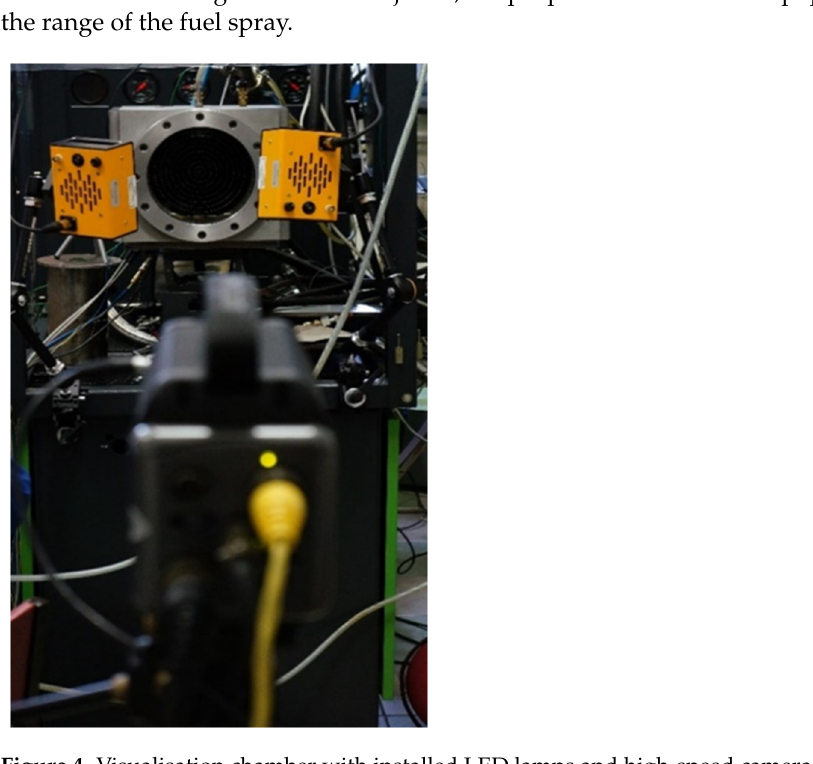
Figure 4. Visualisation chamber with installed LED lamps and high-speed camera.